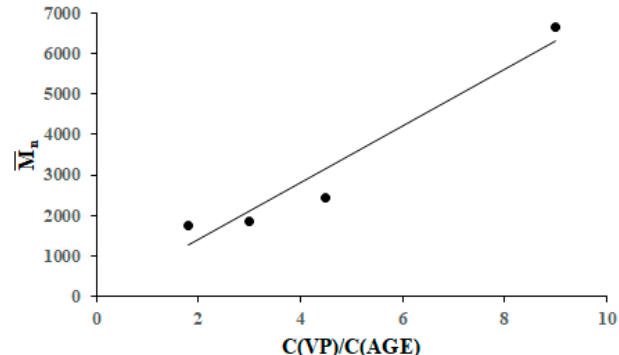
Figure 5. Dependence of the number-average molecular weight of the amphiphilic copolymers of N-vinyl-2-pyrrolidone and allyl glycidyl ether on the ratio of monomers in the reaction system. (cid:3364)(cid:3364)(cid:3364)(cid:3364) Linear regression, M (cid:2924) vs. (C(VP))/(C(AGE)), yields Equation (4), which is charac- terized by a Fisher parameter of 33.38 and a tabular F-test value of 18.51 ( α = 0.05).